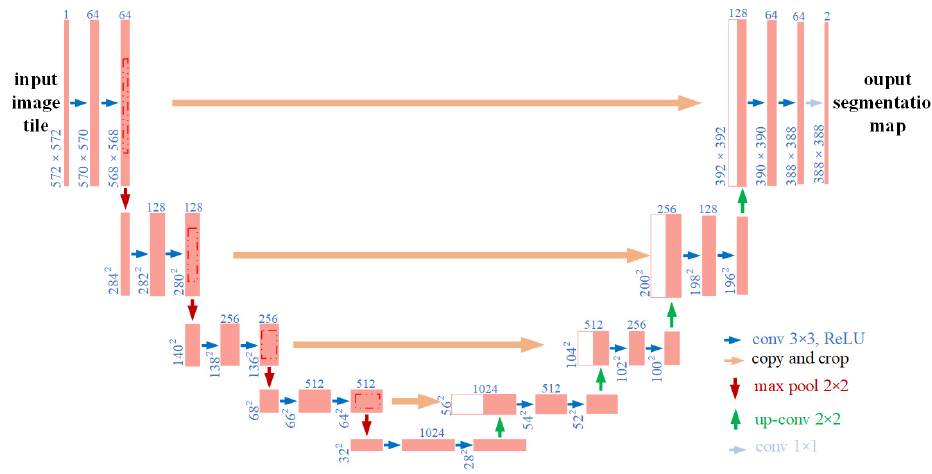
Figure 2. The difference between CNN and FCN.